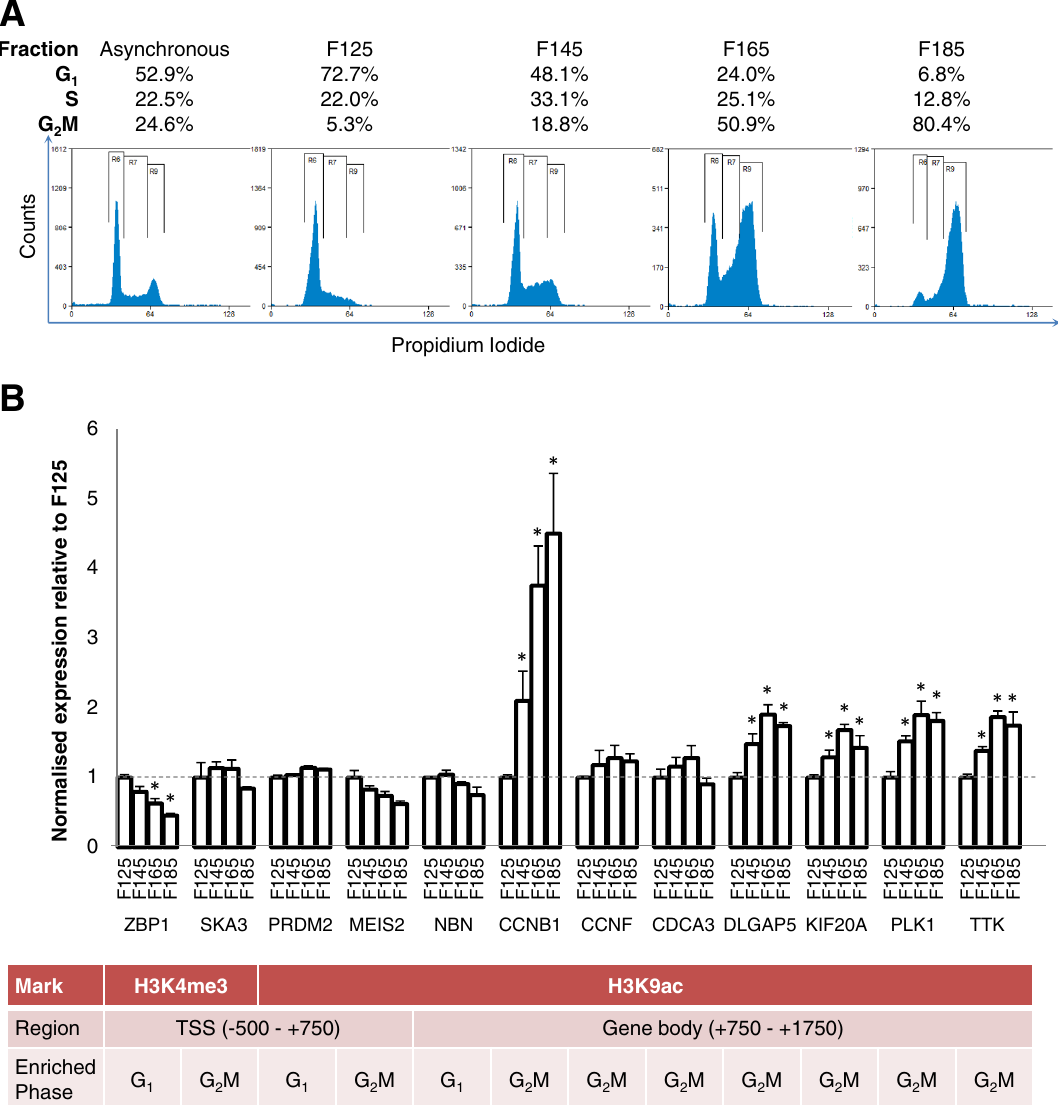
Figure 6. H3K9ac gene body enrichment in G 2 M in LCL is associated with ongoing transcription. ( A ) LCL were fractionated by centrifugal elutriation. Elutriated fractions were fixed and stained with propidium iodide to determine cell cycle stage. The proportion of cells in G 1 , S and G 2 M for each elutriated fraction is shown above each plot. ( B ) Cell-cycle specific expression of genes with significant TSS enrichment was measured by RT-qPCR with primers to nascent pre-mRNA, normalised to the housekeepers β-actin, beta-2-microglobulin, RPLI3A and HPRT. Genes were enriched in H3K4me3 at the TSS in G 1 (ZBP1) or G 2 M (SKA3), H3K9ac at the TSS in G 1 (PRDM2) or G 2 M (MEIS2) or in the gene body (+ 750–+ 1750) in G 1 (NBN) or G 2 M (all remaining genes). *P < 0.05 relative to